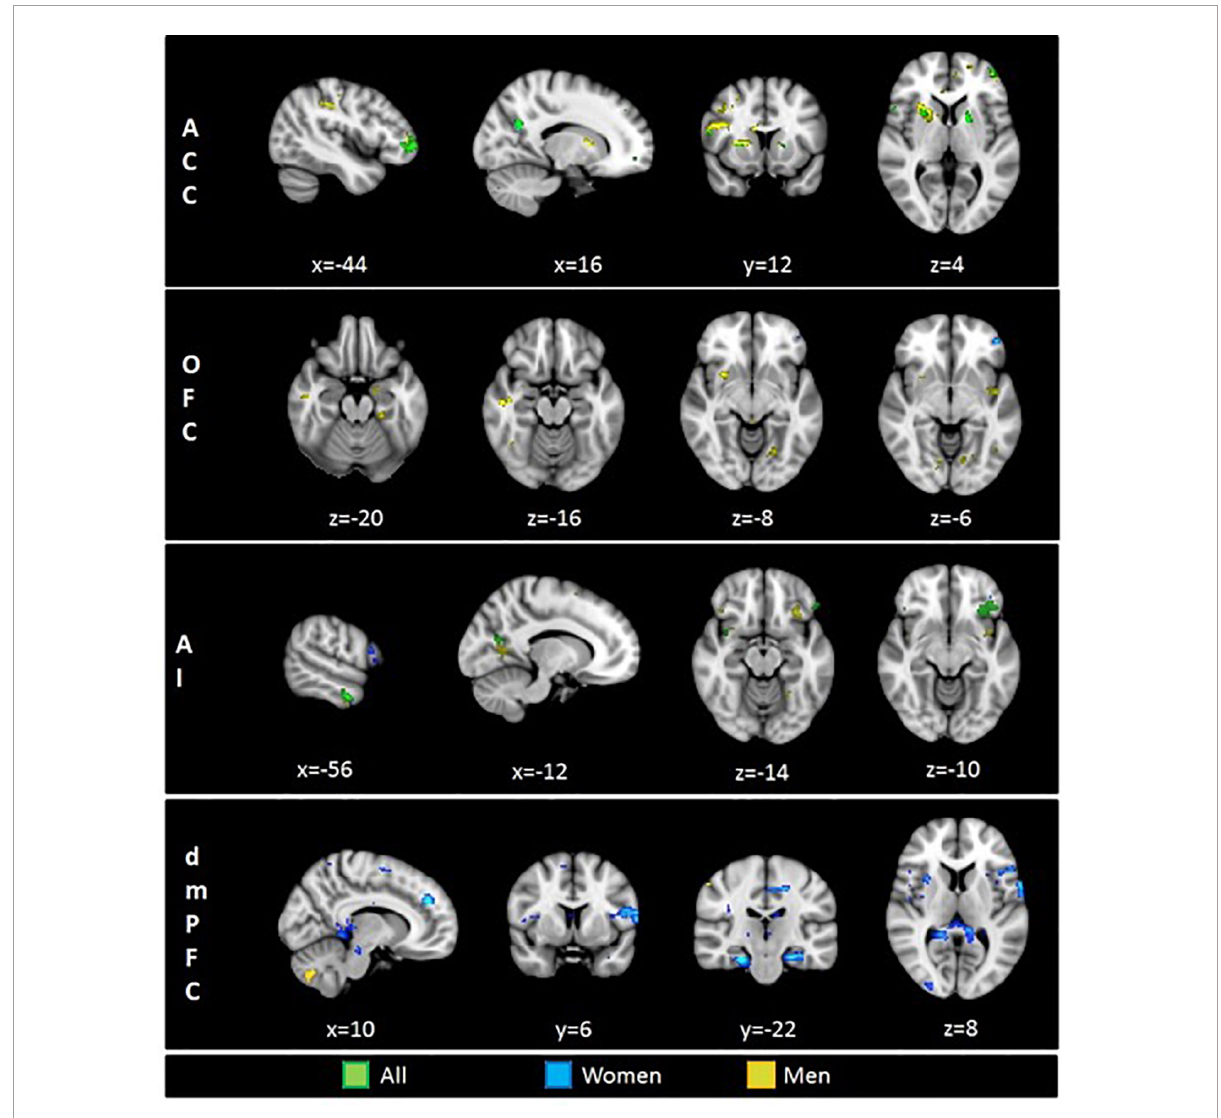
FIGURE2 Brain regions functionally connected with four seed regions of interest (ROI): ACC, anterior cingulate cortex; OFC, orbitofrontal cortex; AI, anterior insula; dmPFC, dorsomedial prefrontal cortex. Displayed colors represent tree different groups: Green–Full sample, Blue–Women, Yellow–Men. Results at p <